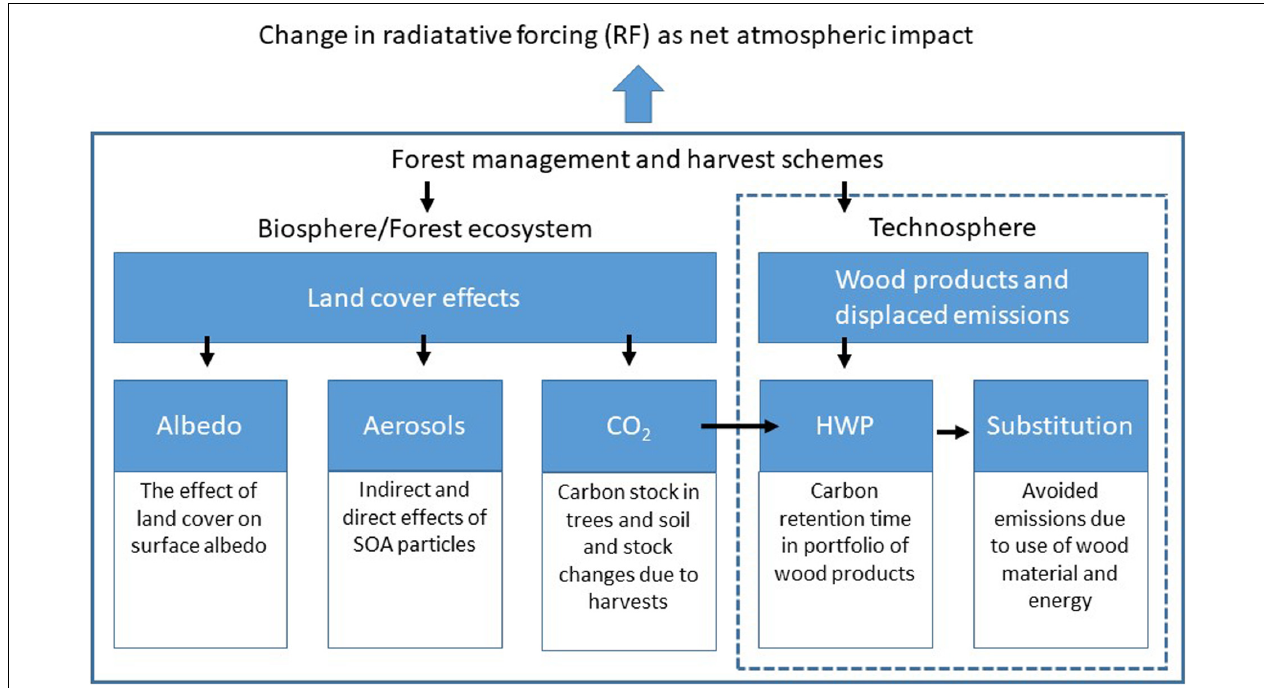
FIGURE 1 | Schematic presentation of the study. We simulated the stand development [changes of carbon storage in trees, soil, and harvested wood products (HWP)] of most common Finnish tree species at representative forest types (sub-xeric Scots pine, mesic Norway spruce, herb-rich Norway spruce, and herb rich Silver birch) at the current climate and compiled an expression of Finnish forests using recent National Forest Inventory data (NFI). Based on literature values we estimated the potential of avoided emissions obtained with wood use. Using this information, we calculated how a change in state of forests in Finland influenced global radiative forcing (RF) during 50 years relative to the baseline assuming different policy options for harvesting [annual harvest 50–130% of current annual forest growth